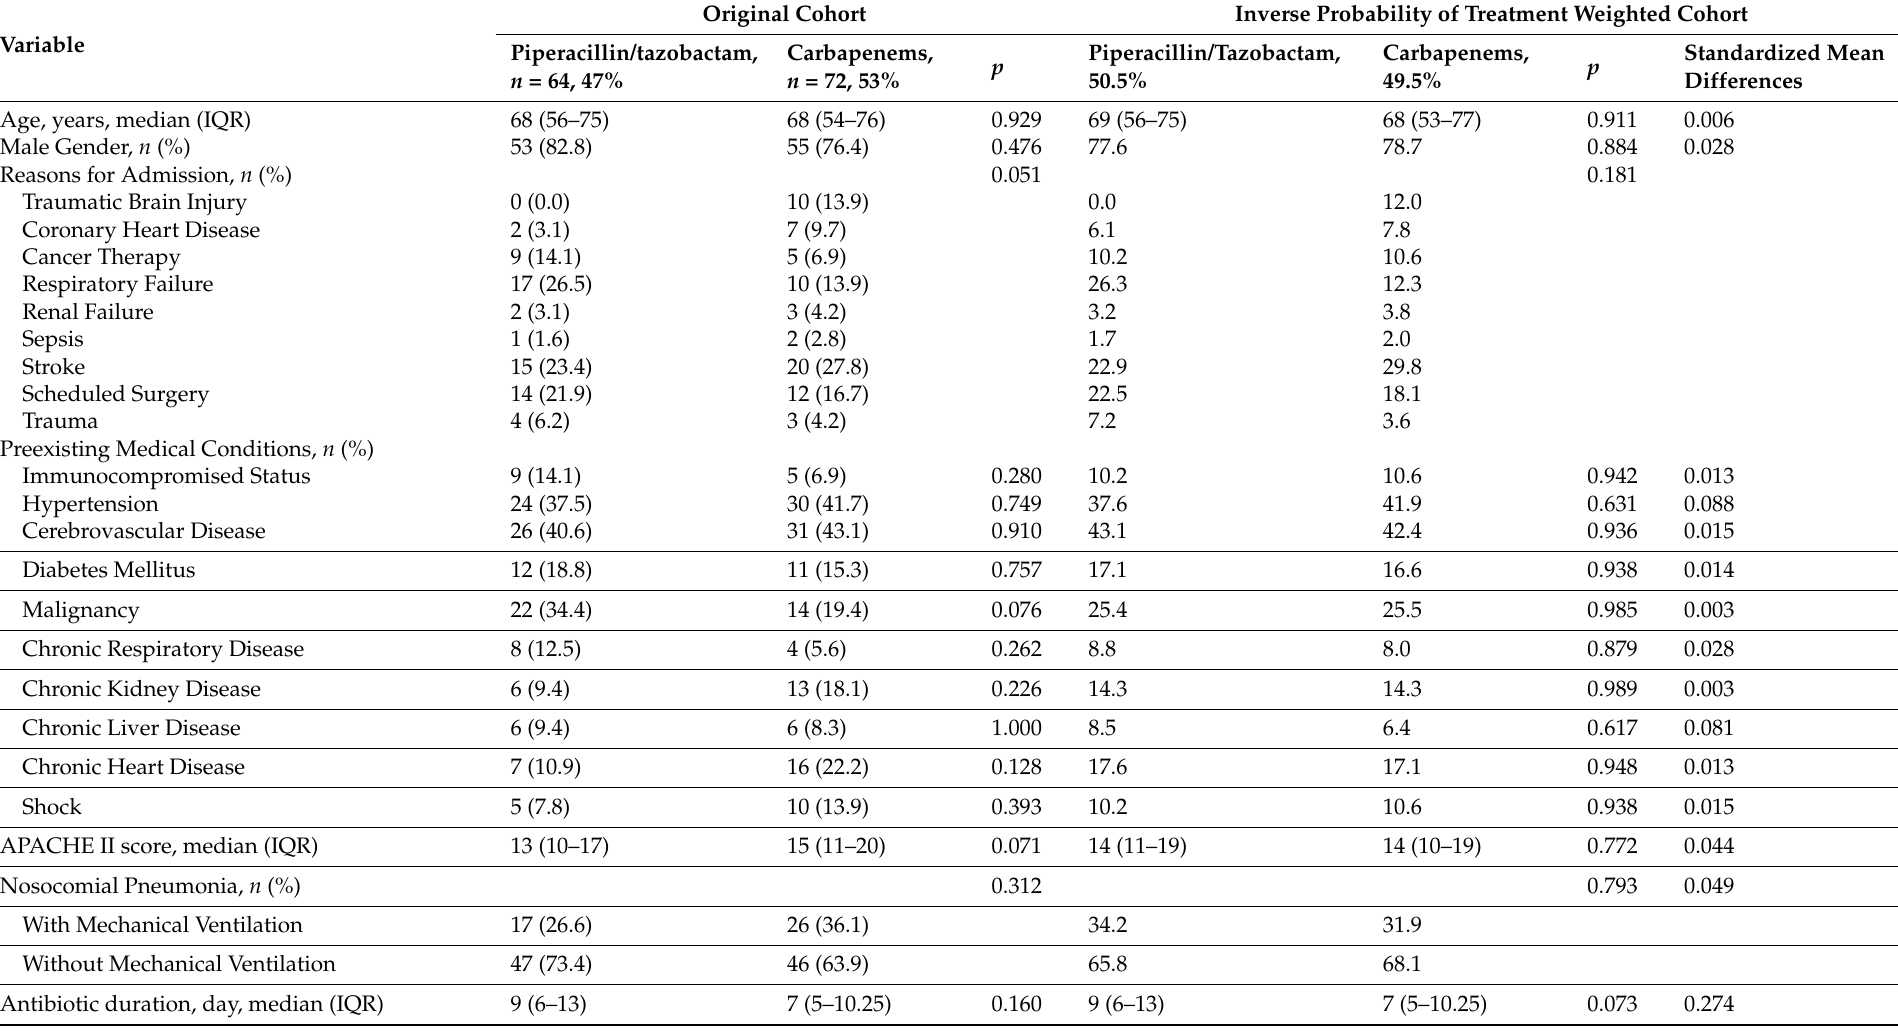
Table 1. Characteristics of patients with nosocomial pneumonia caused by ESBL-producing K. pneumoniae